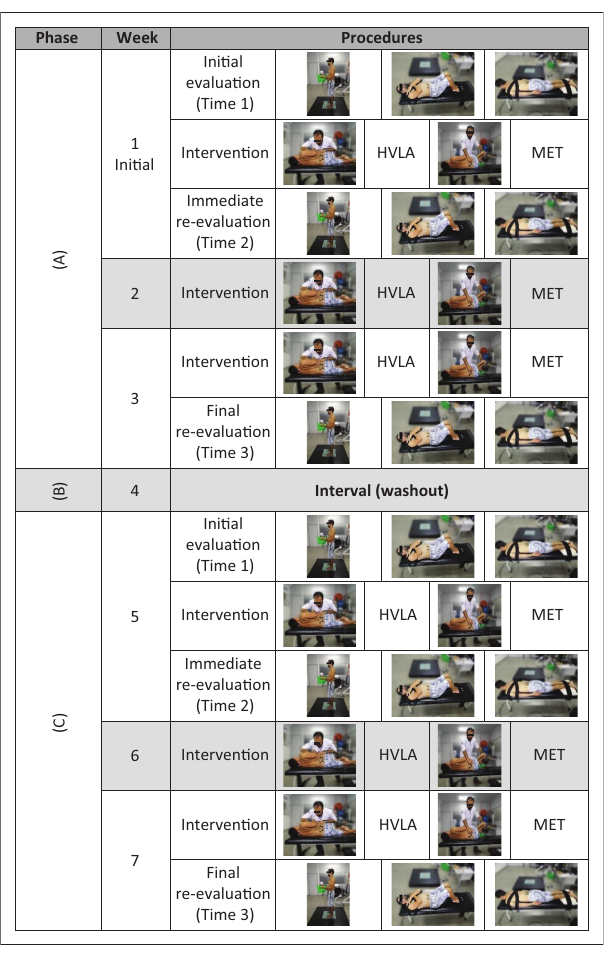
FIGURE 4: (a) High-velocity low-amplitude manipulation thrust manipulation positioning and (b) muscle energy technique positioning.